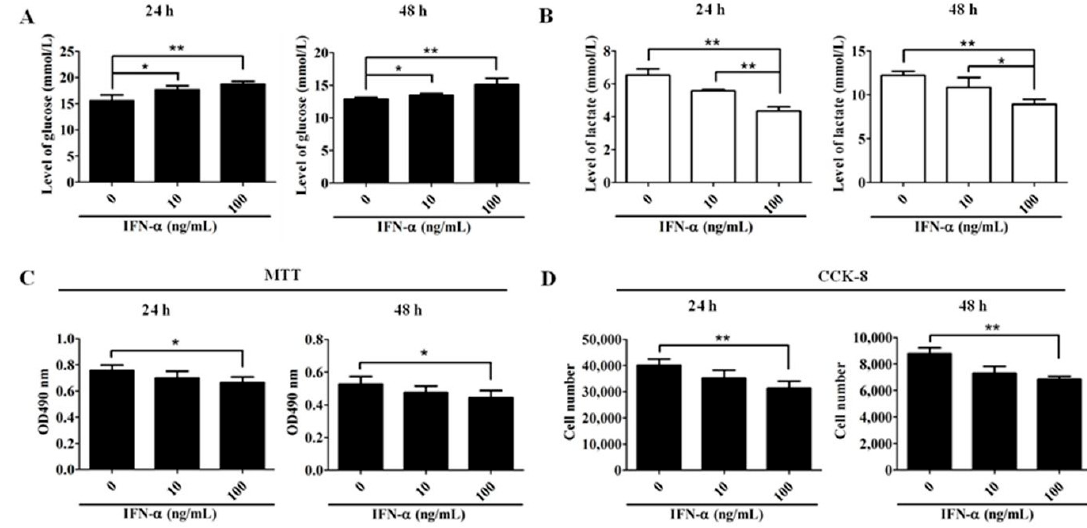
Figure 1. Interferon α (IFN- α ) inhibits the proliferation of human cervical cancer cell line, HeLa cells. The detection of glucose ( A ) and lactate ( B ) levels in IFN- α -treated HeLa cell culture medium. HeLa cells were treated with increased doses (0, 10, and 100 ng/mL) of IFN- α for 24 and 48 h, respectively. The glucose and lactate levels presented in cell culture medium were detected by Biosen C-Line. Each value is represented as mean ± SD from three independent experiments; ( C ) MTT (3-(4,5-dimethylthiazol-2-yl)-2,5-diphenyl tetrazolium bromide) analysis on cell proliferation. HeLa cells were treated with increased doses (0, 10, and 100 ng/mL) of IFN- α for 24 and 48 h. The treated HeLa cells were collected and assayed by MTT. The reaction products were measured at 490nm with a plate reader. Each value is represented as mean ± SD from three independent experiments; ( D ) Cell-Counting Kit (CCK)-8 analysis on cell proliferation. After treatment with increased doses (0, 10, and 100 ng/mL) of IFN- α , the treated HeLa cells were collected and assayed by CCK-8 kit. The reaction products were measured at 450 nm with a plate reader. The variable cell number for each dose was calculated against the standard curve. Each value is represented as mean ± SD from three independent experiments. After statistical analysis, results were considered to be significant if p < 0.05 (*) or p < 0.01 (**).